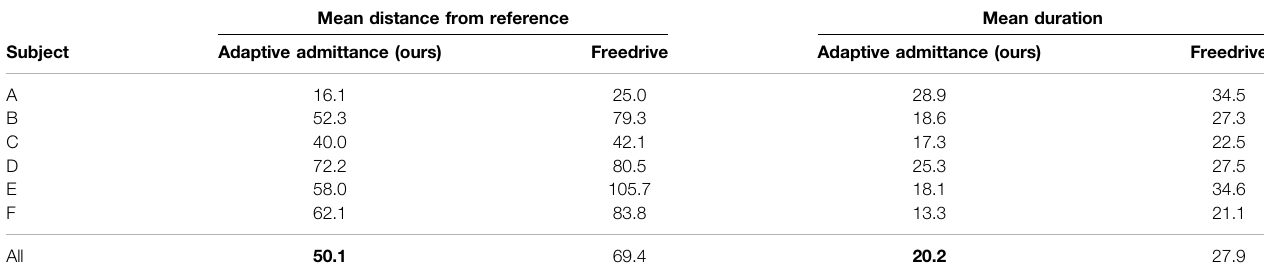
TABLE 1 | Comparison of the mean distance from reference (lower is better) and mean duration (lower is better) between our adaptive admittance controller and Universal Robots ’ freedrive controller for an experiment with six subjects. Each number is an average of three attempts performed by that subject. Mean distance from